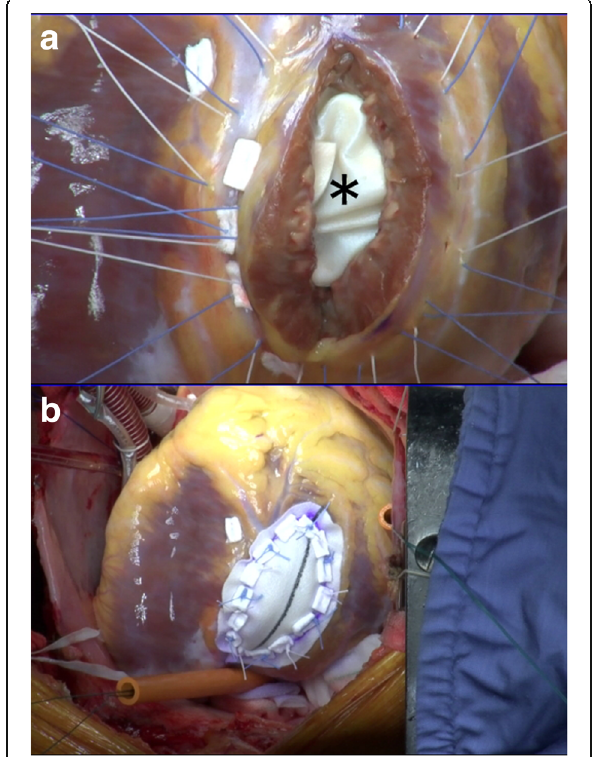
Fig. 4 Closure of the free wall defect. a The “ tail ” of the secondary patch (asterisk) was folded over in the left ventricle and stitched from the inside to the outside with 2/0 braided sutures ( ④ in Fig. 1b). b An external patch of Dacron fabric with a width of 30 mm snugged down to close the ventriculotomy defect. The width of the patch should be slightly smaller than that of the stitched area to reduce tension of the internal